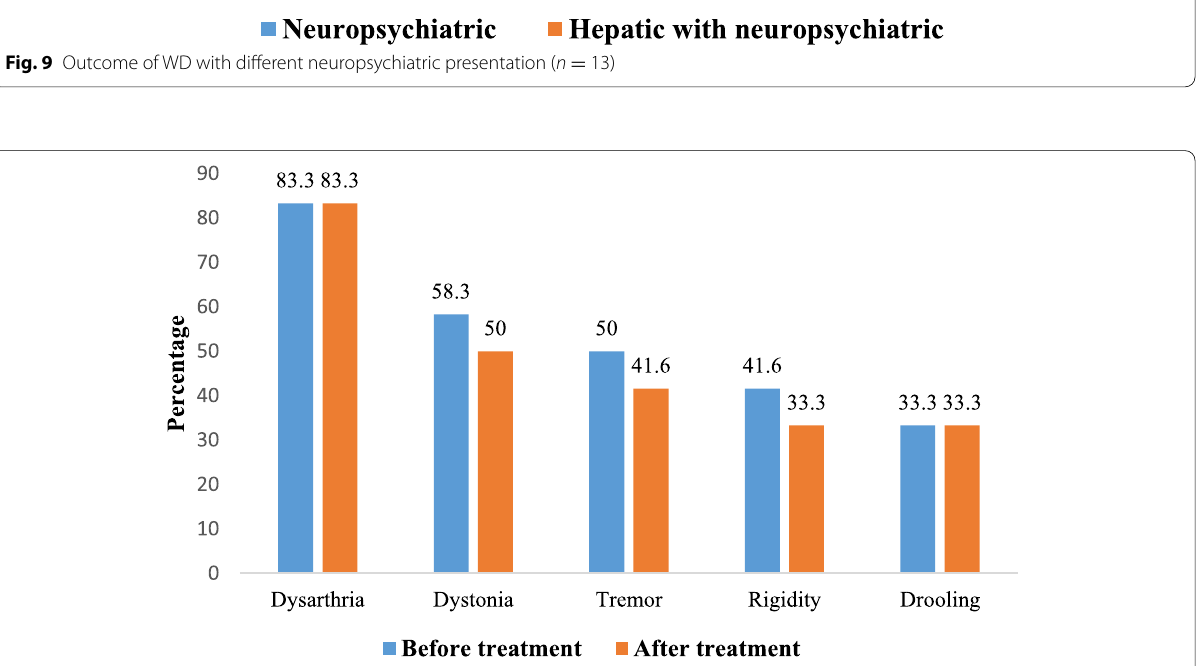
Fig. 10 Clinical improvement in neuropsychiatric WD (survived, n